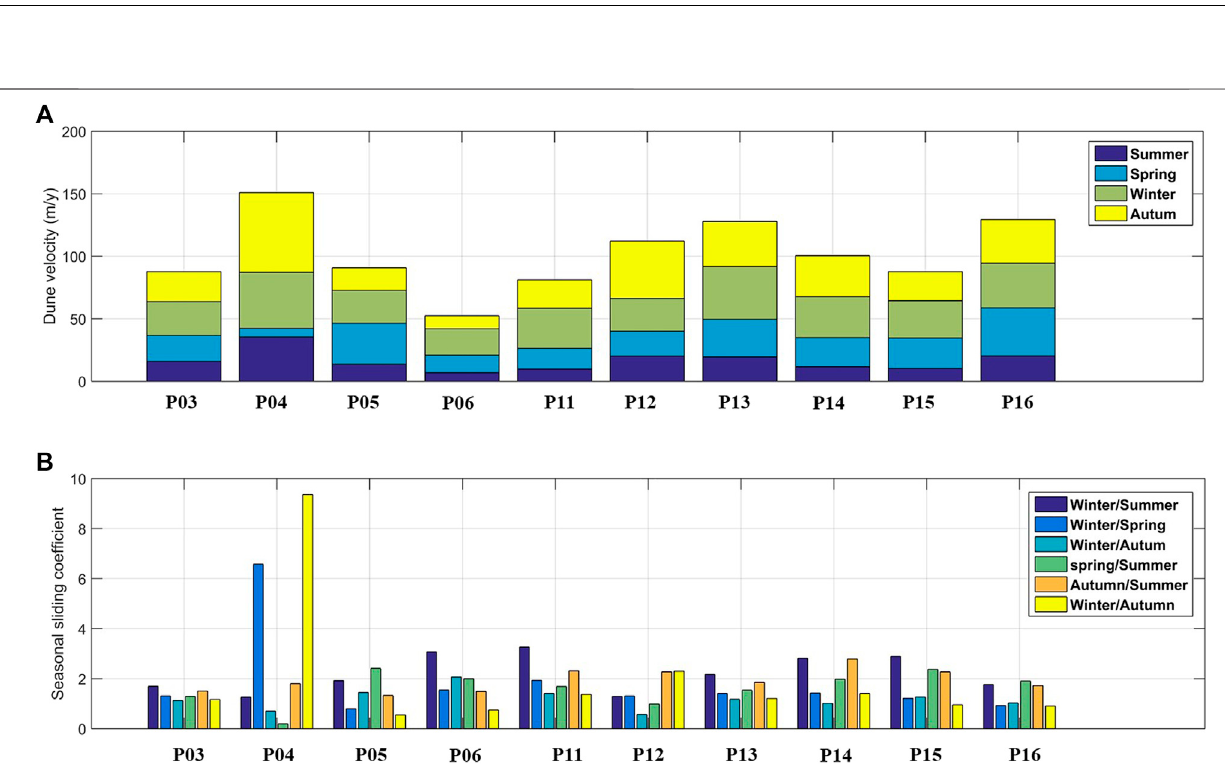
Frontiers in Environmental Science |